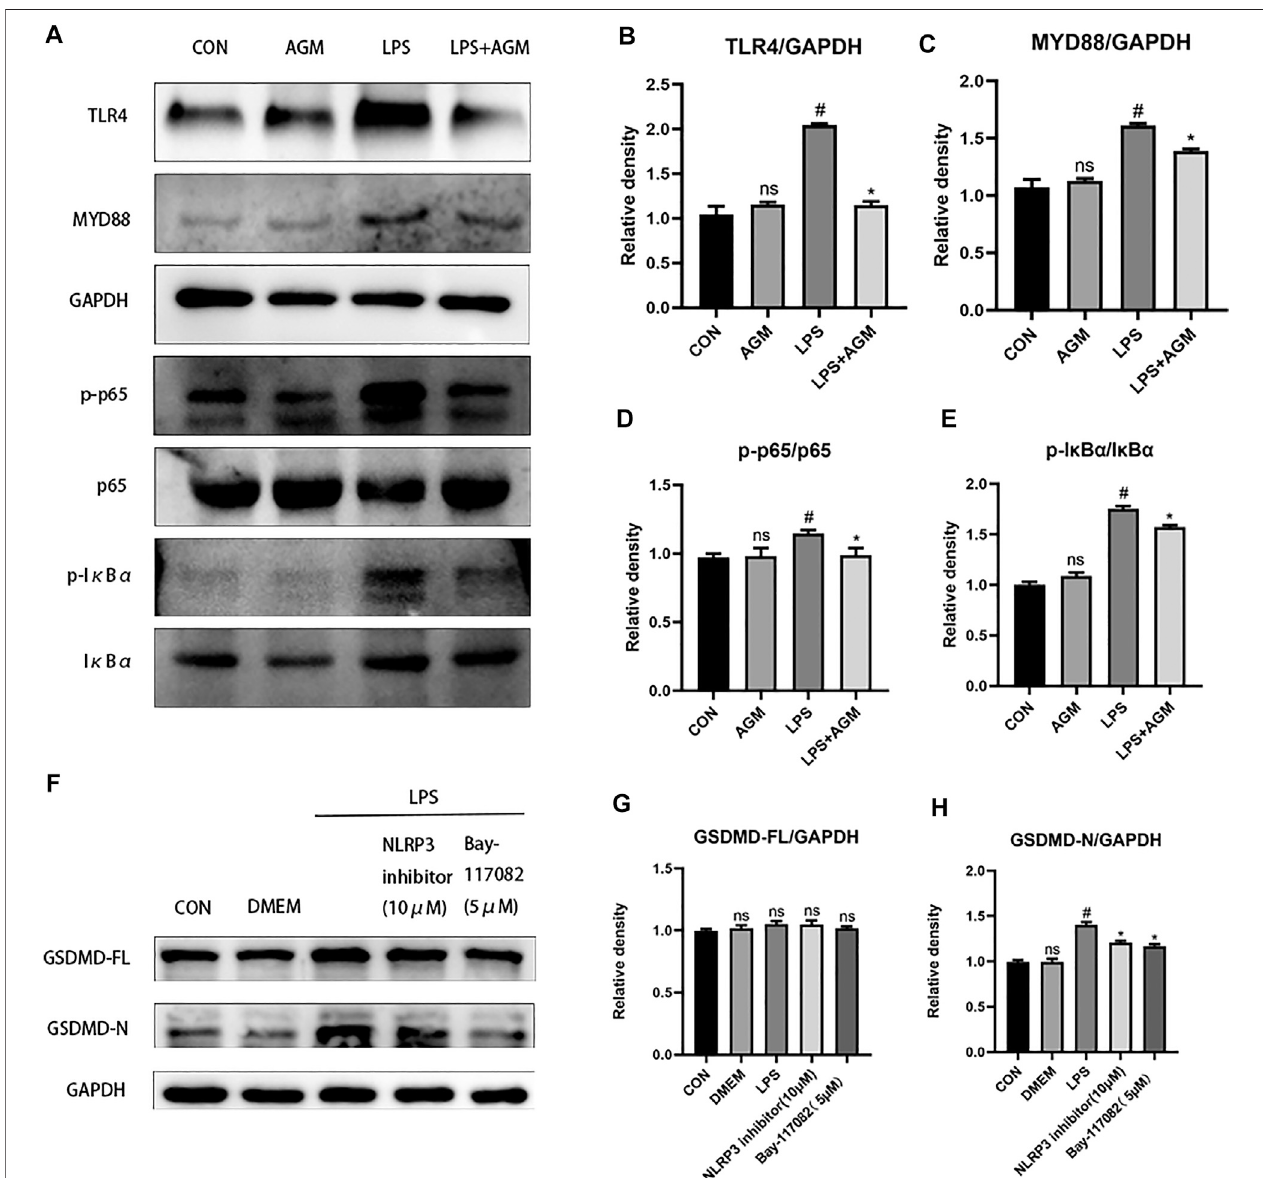
FIGURE 7 | AGM inhibited the TLR4/MyD88/NF- κ B/NLRP3 in fl ammasome pathway in LPS-induced BV2 microglial cells. (A – E) Proteins expression level of in fl ammasome pathway (TLR4, MYD88, p-p65, p65, p -I κ B α , I κ B α ) in different groups (Student ’ s test). (F – H) Proteins expression level of GSDMD-FL and GSDMD-N in differentgroups (Student ’ stest). All data areshown asmean ± standard deviation.# p ＜ 0.05 vs thecontroland LPSgroup, * p ＜ 0.05 vs theLPS group and LPS + AGM group. * p ＜ 0.05 vs the LPS group and NLRP3 inhibitor (10 μ M), Bay-117082 (5 μ M).